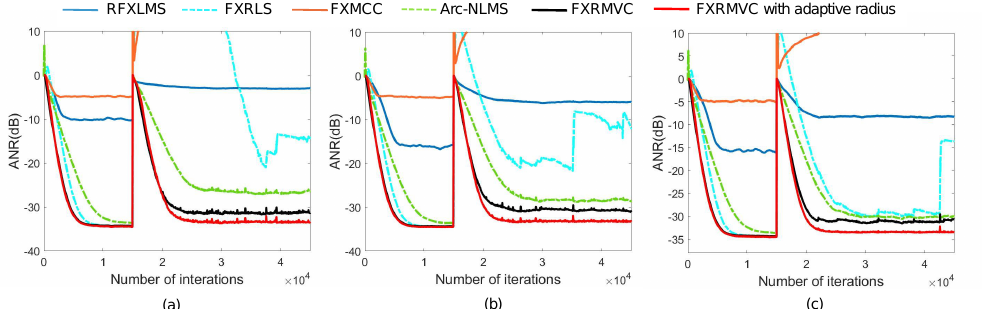
Figure 9. ANR comparison under mixed Gaussian noise and impulse noise: ( a ) α = 1.2, ( b ) α = 1.4 and ( c ) α = 1.6.